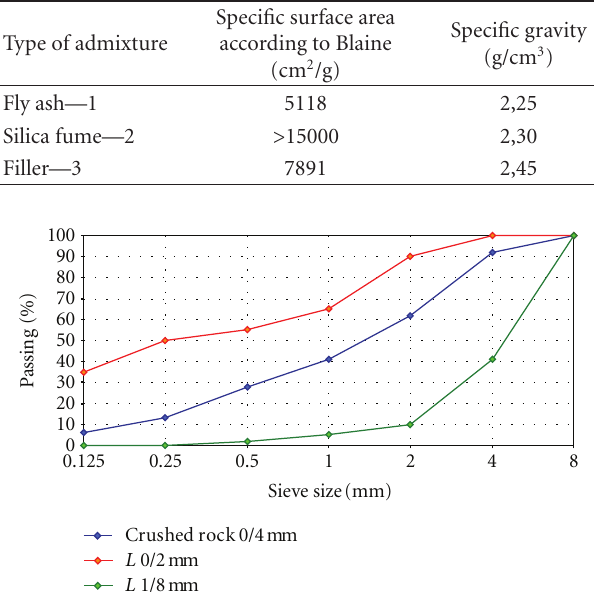
Figure 1: The grain size distribution curve of the aggregates.